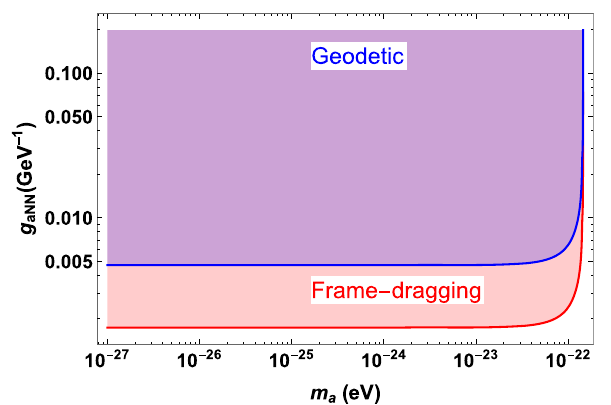
Fig. 3 Variation of g d with m a for axion EDM coupling from the geodetic (blue) and the frame-dragging (red) measurements using GP- B result. The shaded regions above these lines are